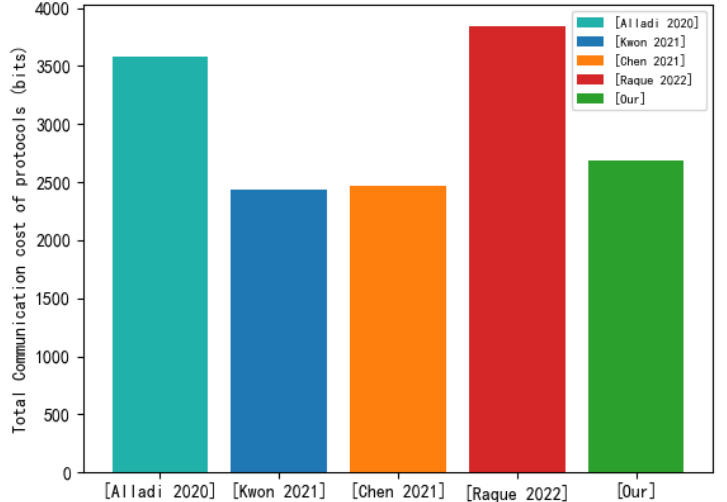
Figure 8. Total communication cost of